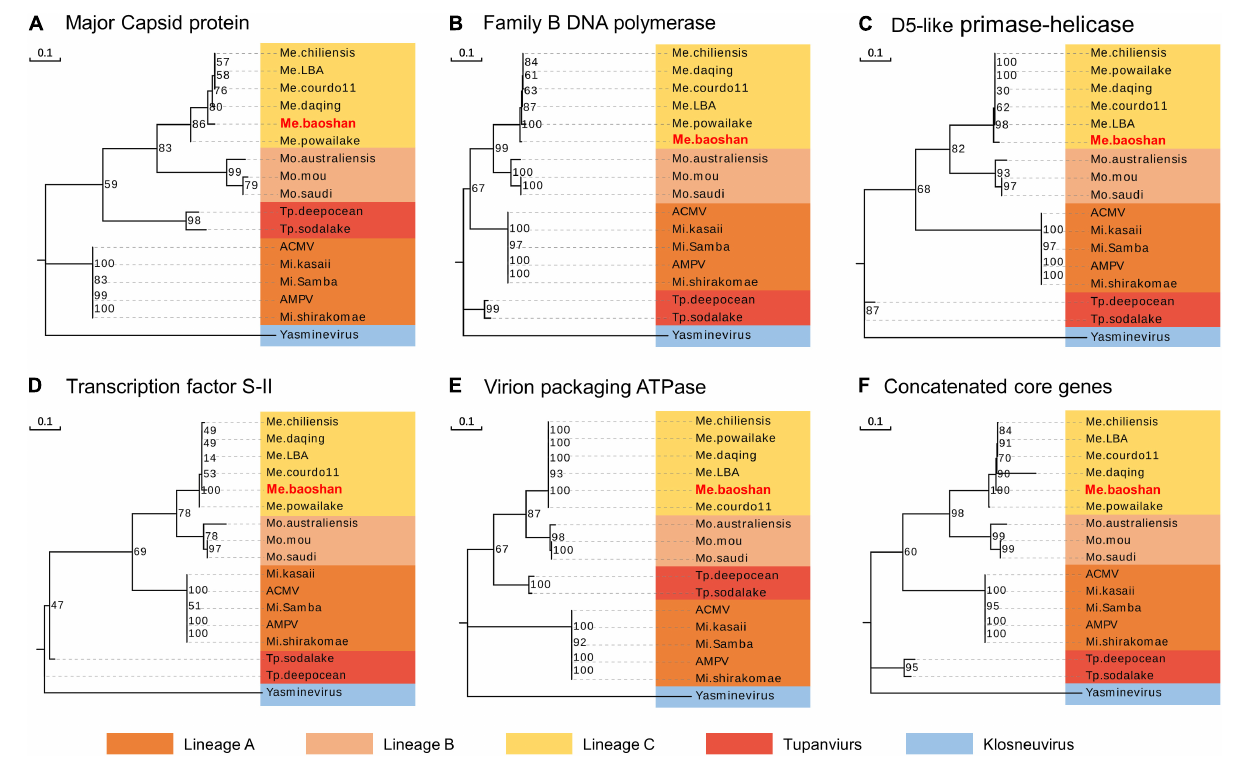
FIGURE 3 | Molecular phylogenetic analysis based on the amino acid sequences of the NCLDV core genes, namely, (A) major capsid protein, (B) family B DNA polymerase, (C) D5-like primase-helicase, (D) transcription factor S-II, (E) virion packaging ATPase, and (F) the concatenated NCLDV core genes consisting of above five genes. Bootstrap consensus tree for 1000 replicates was computed using neighbor joining of maximum likelihood distances. Numbers on each branch represent percentage of trees containing that branch. Background colors represented different lineages of